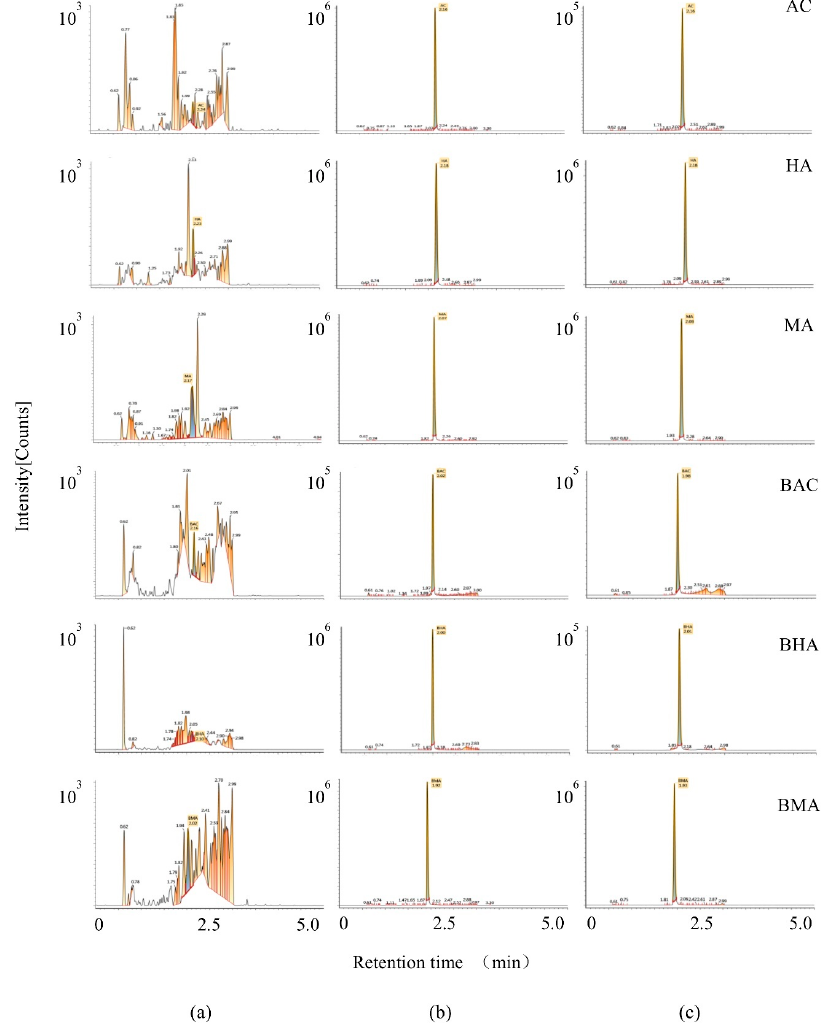
Figure 3. Multiple reaction monitoring (MRM) chromatograms of AC, HA, MA, BAC,BHA, BMA, ( a ) Blank plasma; ( b ) Blank plasma spiked with the six compounds; ( c ) A rat plasma sample after oral administration of Fu Zi extracts (1.0 g/kg).